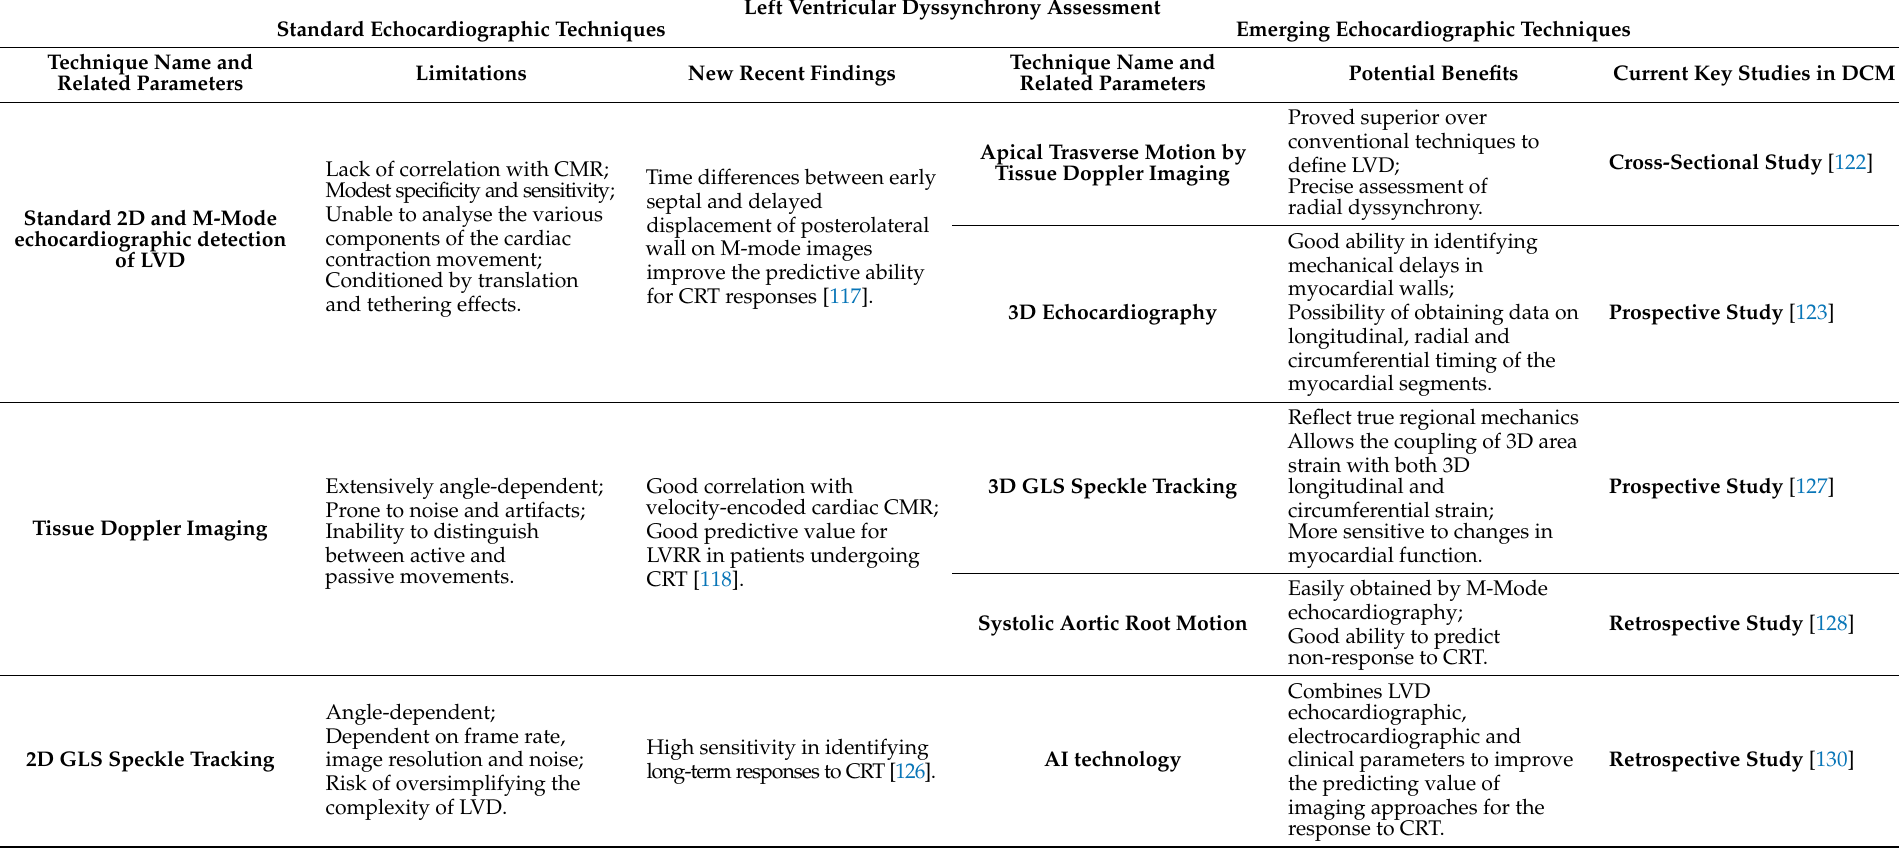
Table 4. Comparison between Standard and Emerging echocardiographic techniques to assess left ventricular dyssynchrony in dilated